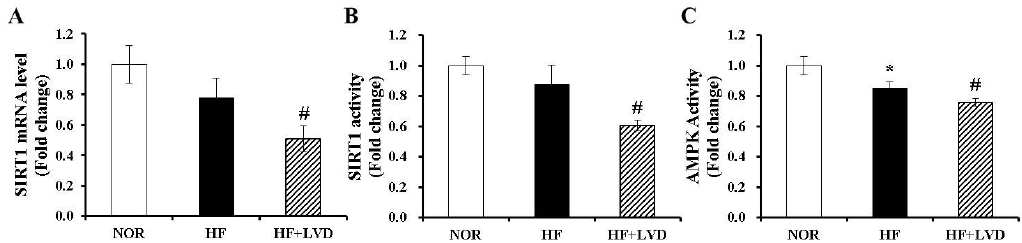
Figure 5. Vitamin D insufficiency decreases mRNA expression and activity of SIRT1 and AMPK activity in adipose tissue. SIRT1 mRNA levels were measured by quantitative RT ‐ PCR and normalized to β‐ actin ( A ); SIRT1 activity was analyzed by a fluorometric SIRT1 activity assay kit ( B ); AMPK activity was measured using an AMPK kinase kit, normalized to their relative protein contents and expressed as the fold change compared to NOR ( C ). The value of each bar represents the mean ± SEM. * p < 0.05 compared to NOR. # p < 0.05 compared to HF. NOR, 10% fat diet with 1000 IU vitamin D ( n = 9); HF, 45% fat diet with 1000 IU vitamin D ( n = 7); HF+LVD, 45% fat diet containing 25 IU vitamin D ( n = 7).